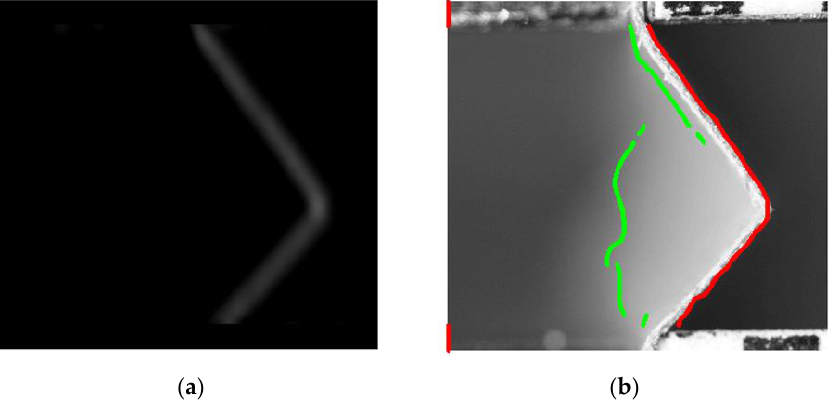
Figure 5. ( a ) The result of filtering the image of the paper sample during the measurement, ( b ) the image of the sample with the detected left edge marked in green and the right edge in red.